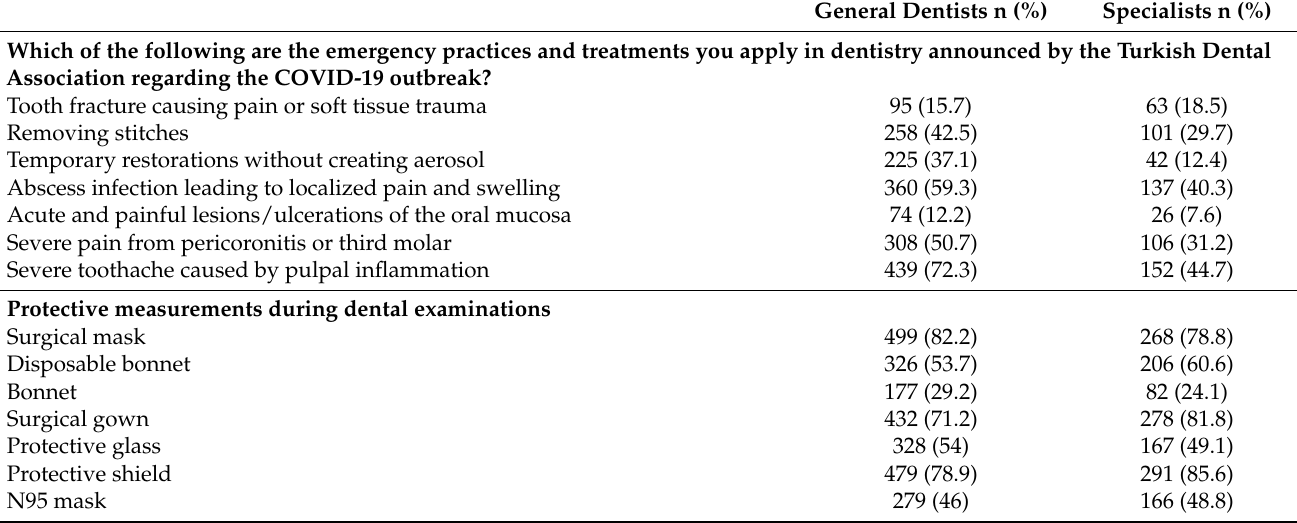
Table 5. The answer rate of participants to the list of emergency practices and treatments declared by Turkish Dental Association (TDA) and protective measurements.